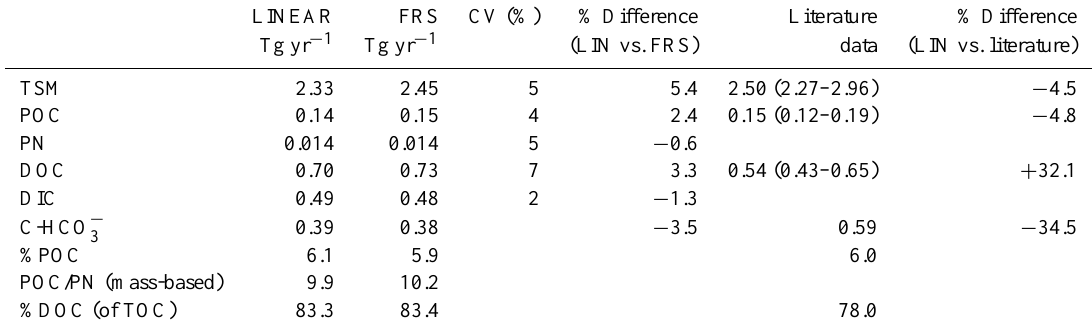
Table 1. Overview of particulate and dissolved fluxes calculated for the Oubangui (March 2010–March 2011), using both linear extrapolations between sampling dates, and using flow-regime stratified Beale’s ratio estimators (FRS, GUMLEAF v0.1). Also provided are the annual weighted %POC, annual weighted POC/PN ratio, and annual contribution of DOC to the total organic C export (%DOC/TOC) based on both approaches. Literature data: from Probst et al. (1994) and Coynel et al. (2005), values in parenthesis are minimum and maximum values for different years from Coynel et al. (2005). % Difference between literature data and this study is based on average values for linear and FRS